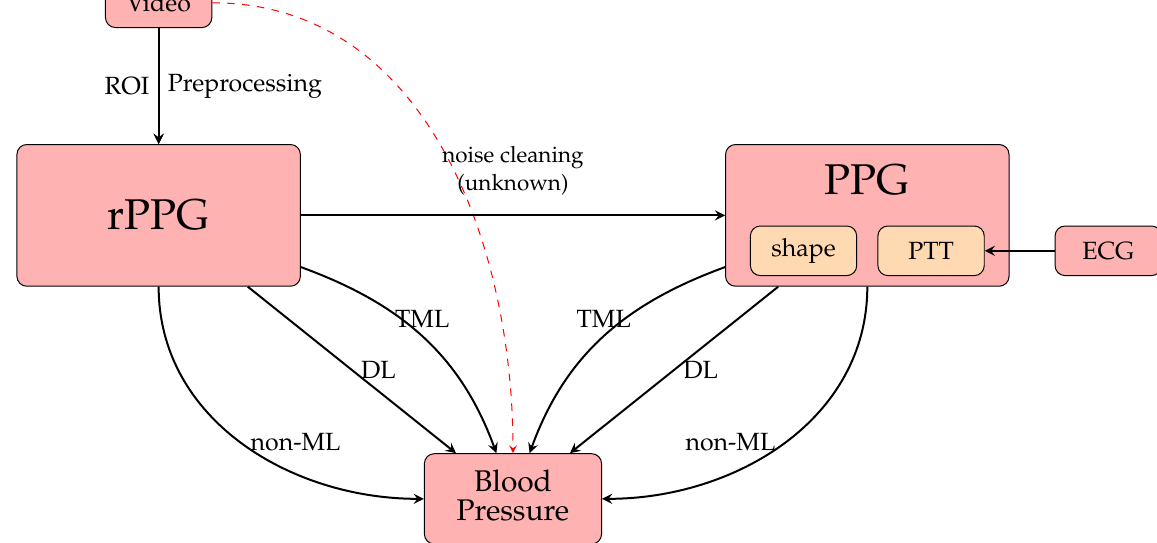
Figure 6. A flowchart showing the research situation in BP measurement. There are 5, 11 and 30 pieces of work using non-ML, ML and DL methods respectively to predict BP from PPG signals, while there are 4, 8 and 7 pieces of work using non-ML, ML and DL methods respectively to predict BP from rPPG signals. ROI preprocessing means preprocessing of data received from some regions of interest on a human face recorded on video. The red dotted line means that there are no research papers talking about the techniques from a video for BP measurement.